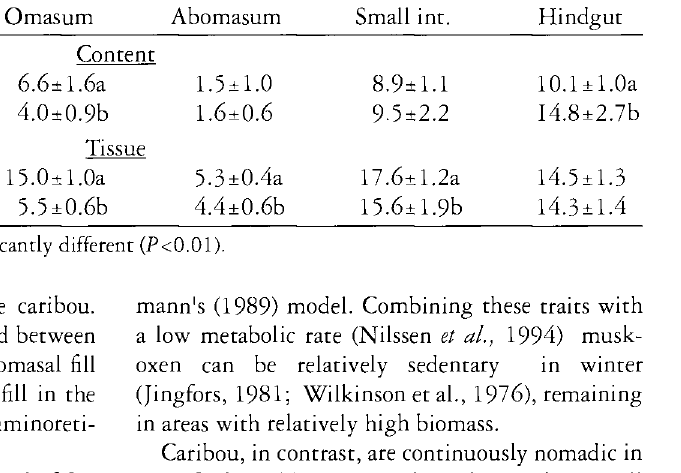
Table 1. Content and tissue weight of sections of the alimentary tract of 10 female muskoxen and 10 female caribou from Victoria Island. Values are expressed as % of rotal fill or as % total tissue